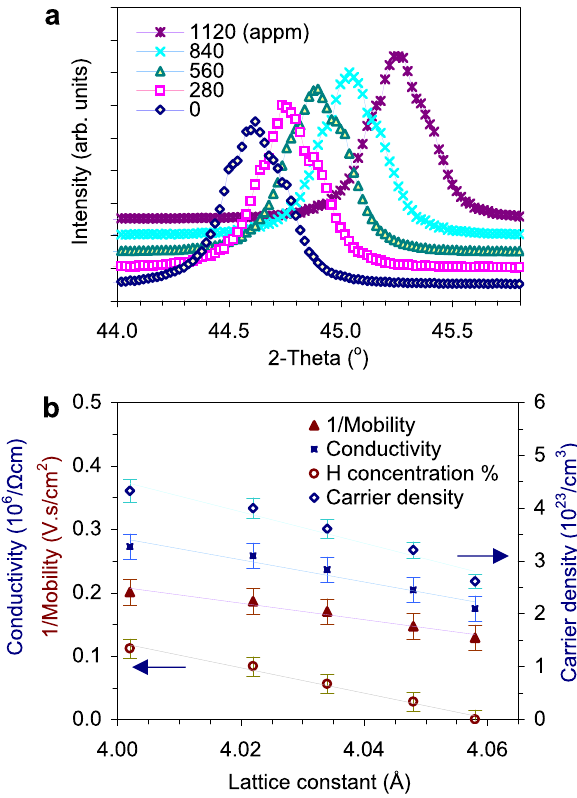
Fig. 1 Hydrogen-implanted gold in the diluted region. a The shift towards higher 2-theta values of the highest diffraction peaks due to increased hydrogen content (0, 280, 560, 840 and 1120 appm) is observed. The SEM images of surfaces of a sample with 560 appm (100 μ C) hydrogen content before and after implantation are shown in Supplementary Fig. 1. b The dependences of the conductivity, carrier density, carrier mobility and H concentration (%, i.e., 10 4 appm) on lattice constant. The lines are drawn to only guide the eyes. Error bars indicate standard deviations.